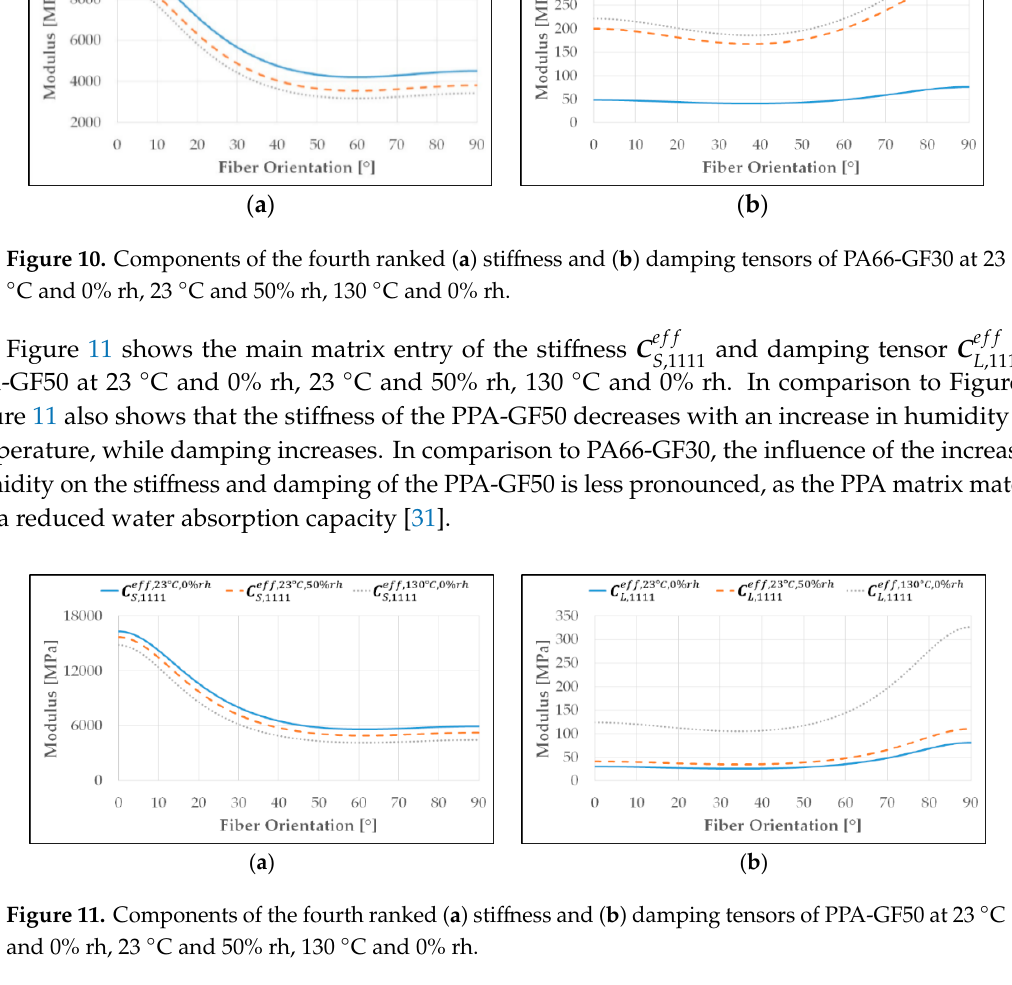
Figure 11. Components of the fourth ranked ( a ) stiffness and ( b ) damping tensors of PPA ‐ GF50 at 23 °C and 0% rh, 23 °C and 50% rh, 130 °C and 0% rh.